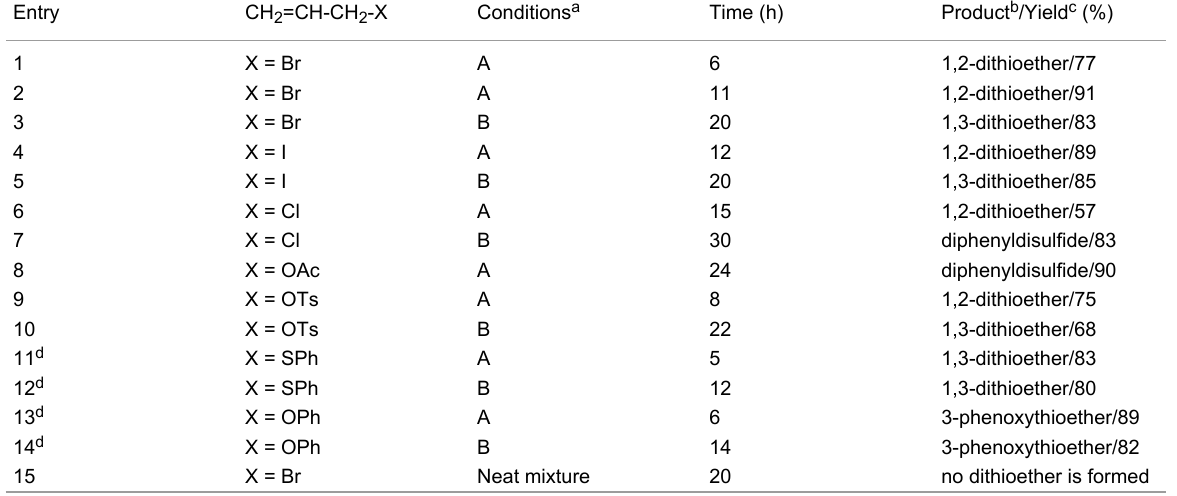
Table 1: Optimization of one-pot sequential substitution–hydrothiolation of allylic substrate with excess benzenethiol over silica at room temperature.